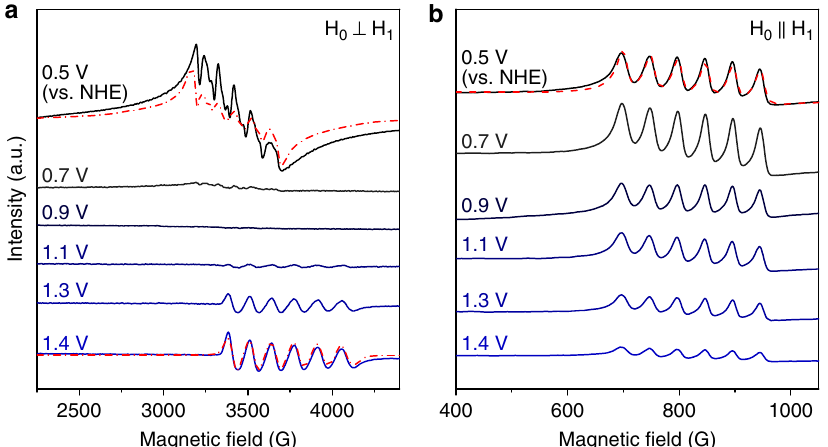
Fig. 3 Measured and simulated potential-dependent EPR spectra. a , b Potential-dependent X-band CW-EPR spectra of Ni – Mn 3 O 4 NPs/NiO in perpendicular ( a ) and parallel ( b ) modes. The dashed red lines are spectral simulations that are well matched with the experimental Fig. 3a and Supplementary Fig. 4, the perpendicular-mode EPR spectrum of potential-applied Ni – Mn 3 O 4 NPs/NiO exhibits a new six-line signal centered at g ~ 1.83, which was not found in the spectrum of non-treated Mn 3 O 4 NPs. This signal continu- ously evolved as the anodic potential increased. To con fi rm the importance of uniform incorporation of Ni into Mn 3 O 4 NPs to